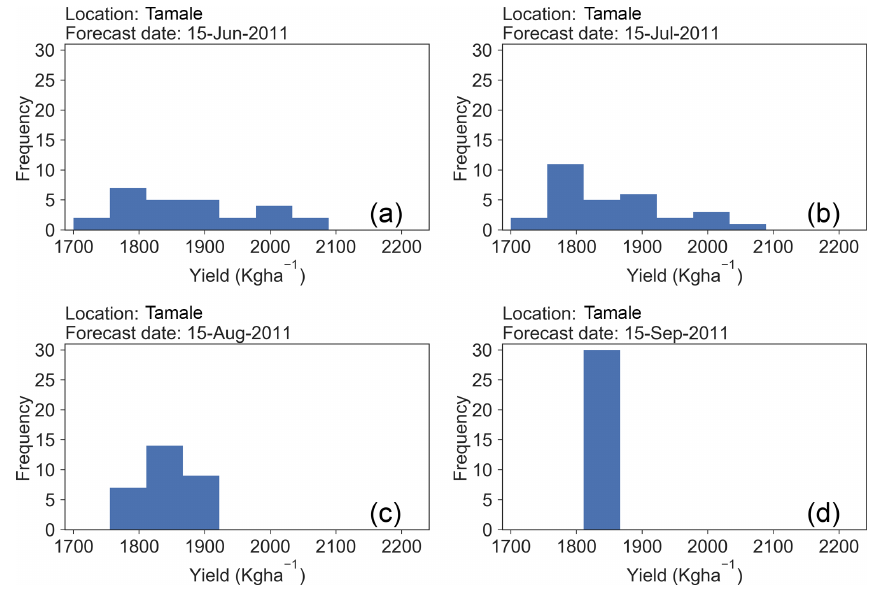
Figure 9. Histograms of yield forecast for (a) 15 June 2011, (b) 15 July 2011, (c) 15 August 2011 and (d) 15 September 2011.